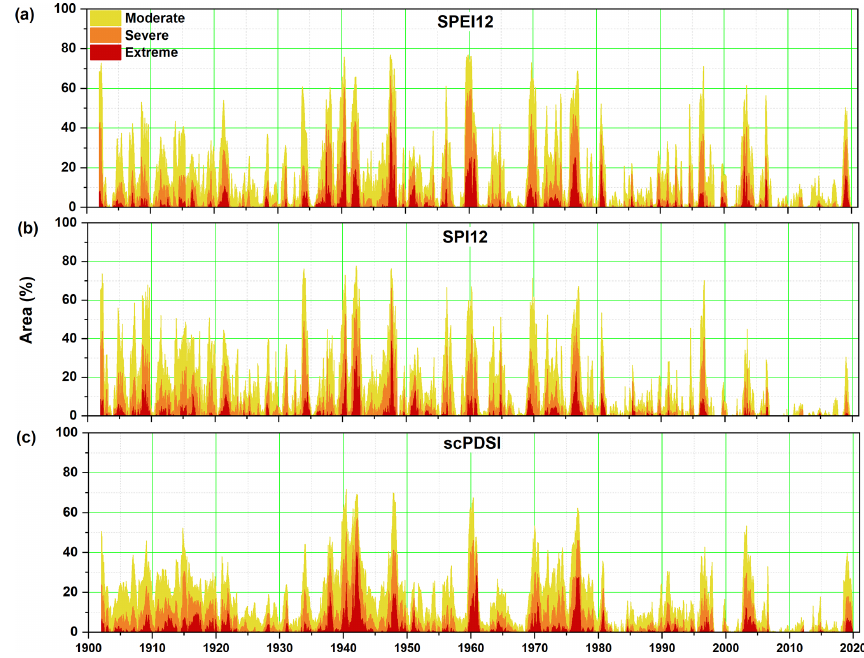
Figure 4. Temporal evolution of the percentage area affected by droughts over NEU for the (a) SPEI12, (b) SPI12, and (c) scPDSI for three drought severity categories: moderate (yellow), severe (orange), and extreme (dark red). See text for the definition of the drought